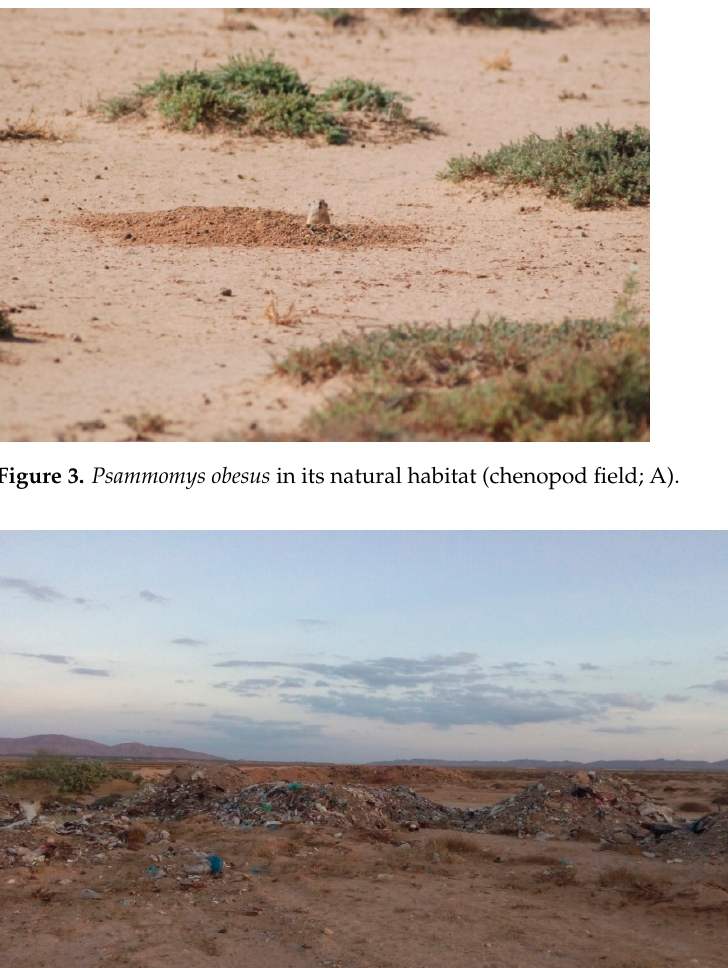
Figure 2. Chenopod fields surrounding villages.